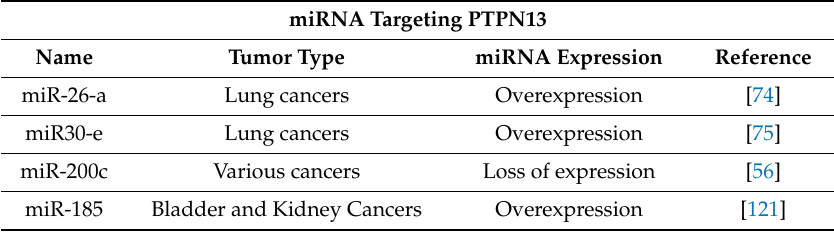
Table 4. miRNA targeting